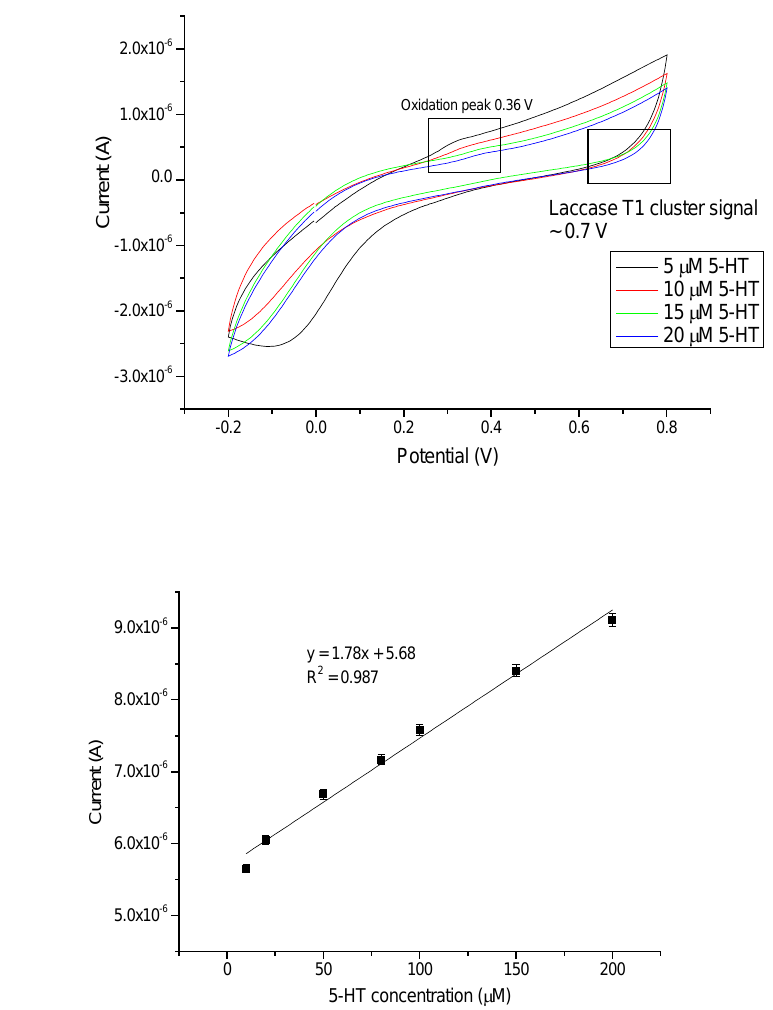
Figure 10. ( A ) Representative CV scans for increasing concentrations of 5-HT (5, 10, 15, and 20 μM) and ( B ) relationship between 5-HT concentration and current (biosensor response).